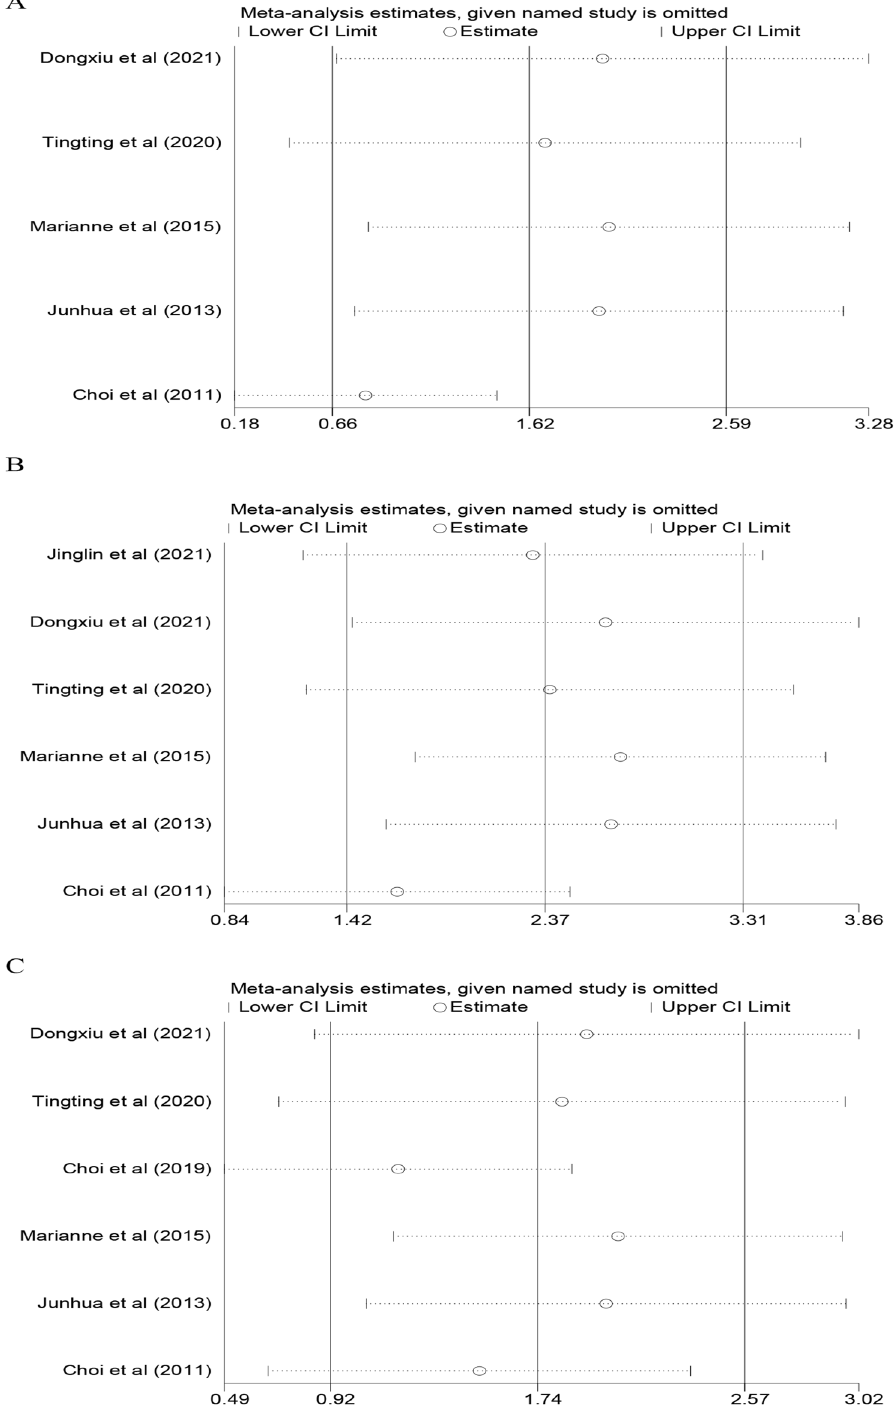
Figure 4. Sensitivity Analysis of all included studies (( A ) FN group and healthy controls; ( B ) FS group and healthy controls; ( C ) FS group and FN